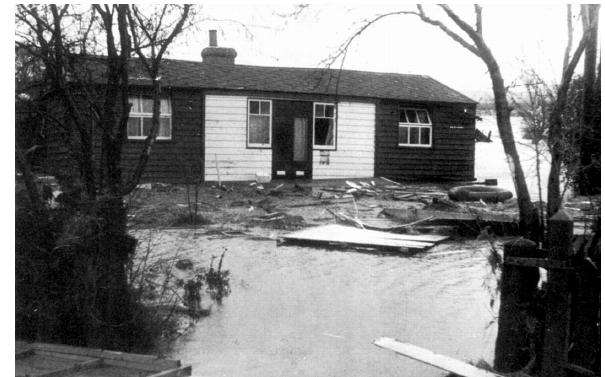
Fig. 10. Improved flood defences built to protect Canvey Island following the 1953 flood. (Source: Baxter, 2005). The following text should have been referenced as follows: